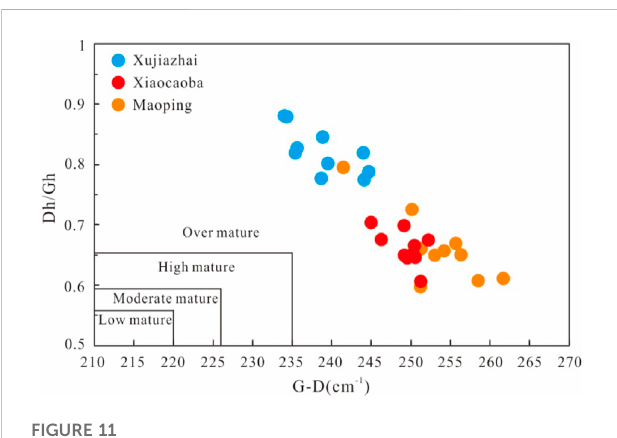
FIGURE 11 Diagram of bitumen maturity (after Zhang et al., 2013).